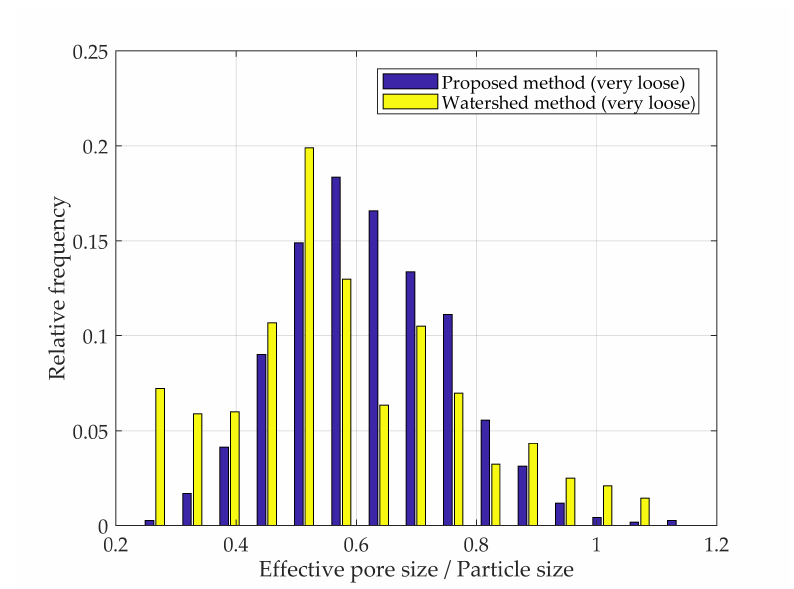
Figure 10. PSD according to the watershed and proposed methods in a very loose mono-sized packed